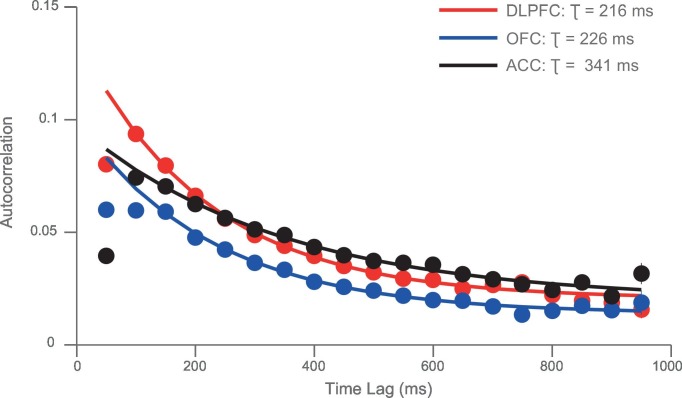
The autocorrelation structure of the DLPFC, OFC and ACC population when trials were filtered for drifts in resting firing rate.Spike count autocorrelation was only performed on trials where the resting firing rate was statistically stationary (see Materials and methods). Similar results were obtained to Figure 2—figure supplement 2.